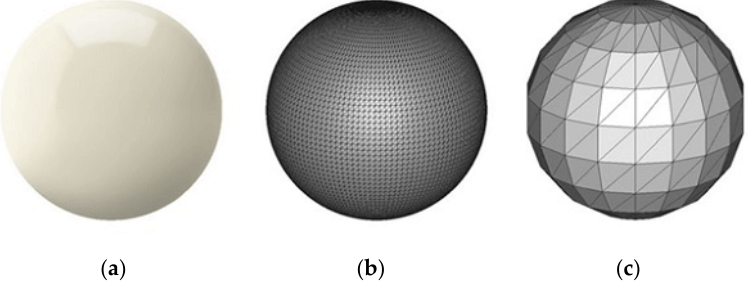
Figure 1. ( a ) CAD, ( b ) high-resolution mesh, ( c ) low-resolution mesh.